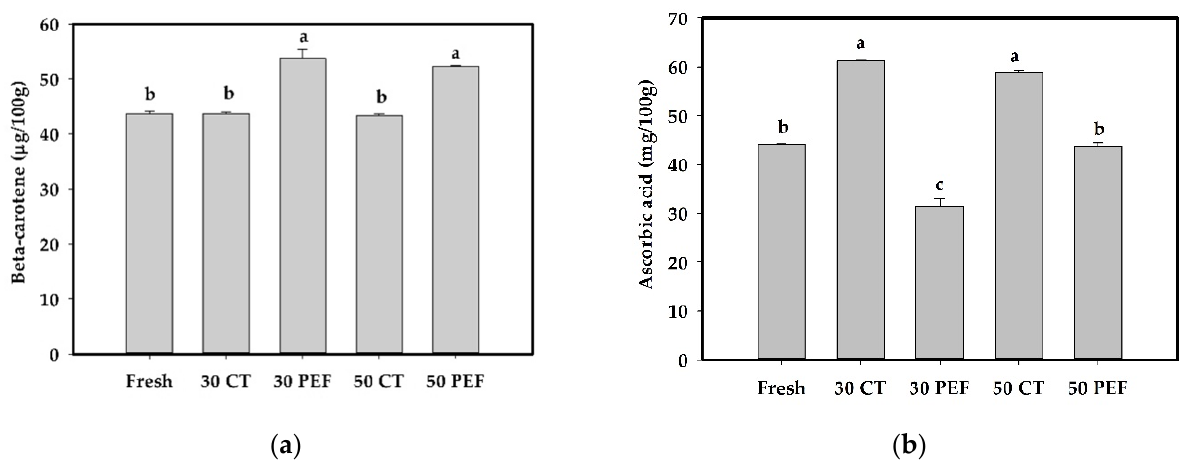
Figure 3. Beta-carotene ( a ) and ascorbic acid content ( b ) of the mango pickled with 30 °Brix and 50 °Brix sugar solutions after the PEF-assisted pickling process at 3 kV/cm, 1 Hz, and 500 pulses in comparison with that of the conventionally pickled mango and fresh mango. The values are expressed as the mean ± standard variation ( n = 3). Duncan’s multiple range test shows that a–c within the same figure are statistically different at p < 0.05.